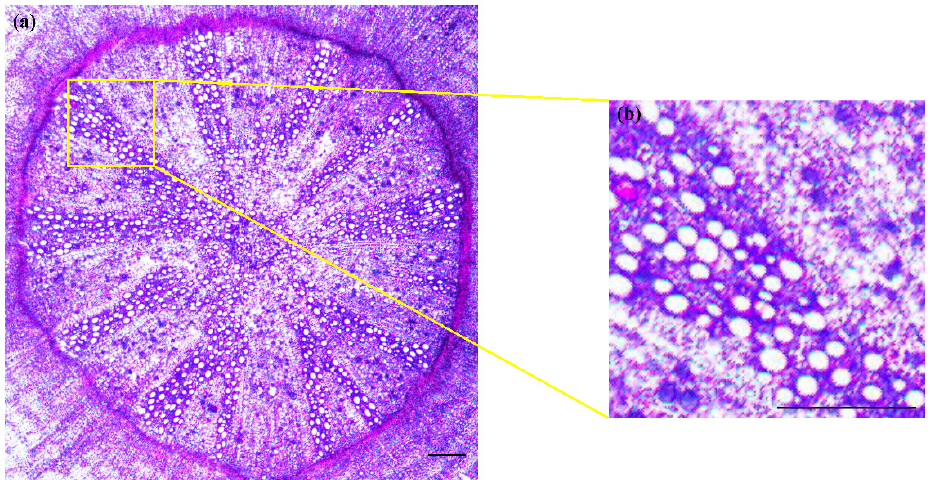
Figure 2. Root cross ‐ section of Potentilla chinensis . ( a , b ) Cross ‐ section from the same individual. The percentage of parenchyma rays in root cross ‐ section ( a ) is 50.96%; the percentage of parenchyma rays in the analyzed area ( b ) is 51.09%. Scale bars = 200 μ m.